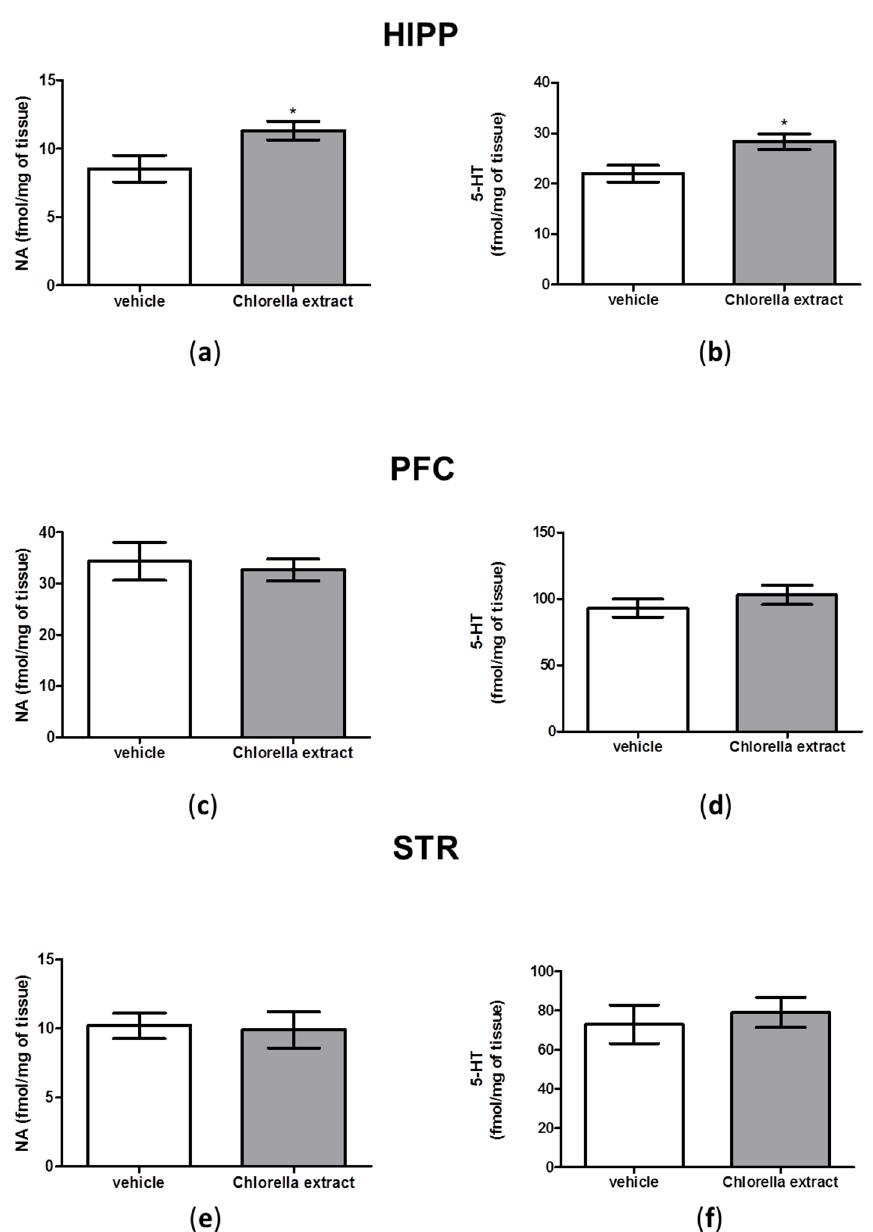
Figure 4. Monoamine quantification in male Wistar rats after Chlorella sorokiniana extract or vehicle administration. NA and 5-HT levels in HIPP ( a and b ); PFC ( c and d ); STR ( e and f ) of male Wistar rats after Chlorella sorokiniana extract (Chlorella extract, 30 mg/kg/mL dark bar) or vehicle (sunflower oil 1 mL/kg, empty bar) administration. Data are expressed as mean ± SEM ( n = 8 per group); ( a ) t -test * p < 0.05 vs. vehicle-treated rats and ( b ) t -test * p < 0.05 vs. vehicle-treated rats.